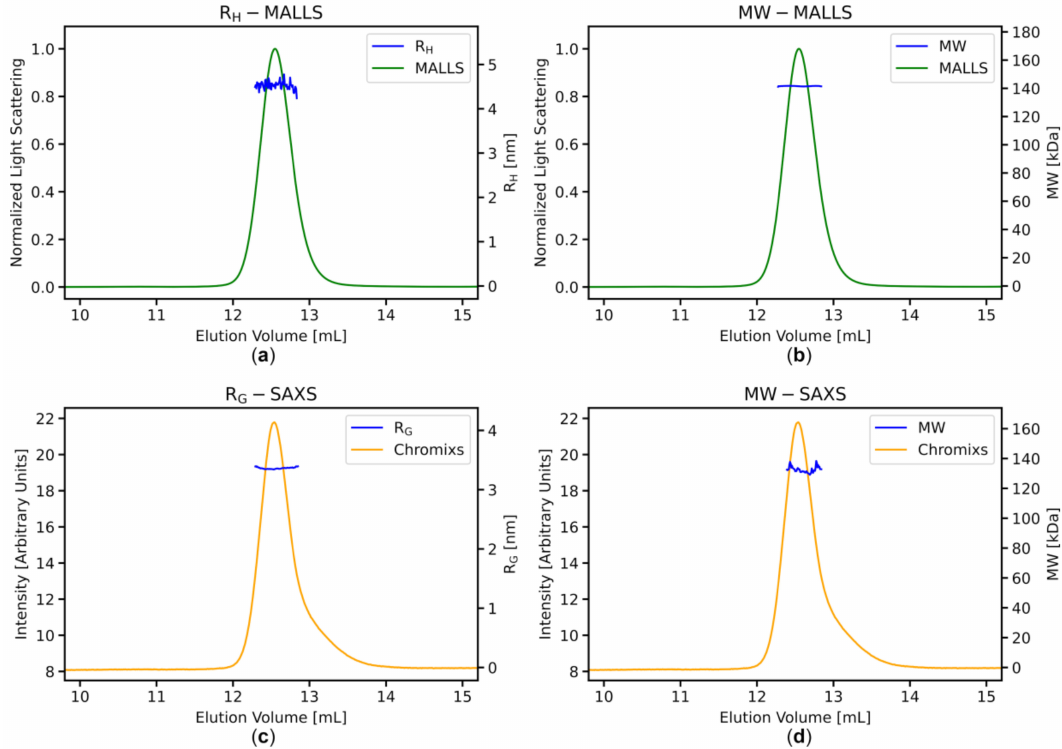
Figure 4. In detail characterization of alcohol dehydrogenase (ADH) elution profiles. ( a , b ) MALLS derived chromatogram—Rayleigh Ratio vs. elution volume in green with stable R H ( a ) and MW MALLS ( b ) across the elution peak. ( c , d ) SAXS-derived chromatogram-integrated intensities vs. elution volume produced by CHROMIXS (in orange) with stable R G values across the elution peak ( c ) and Porod volume-derived MW estimate ( d ). Identical figures for the other four samples are shown in Supplement Figures S2–S5.